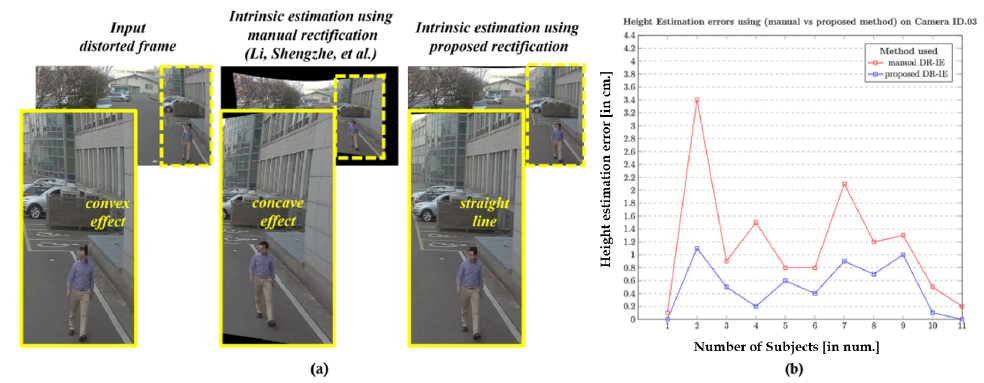
Figure 17. Height Estimation errors using (Li, Shengzhe et al. [31] vs. proposed method) on Outdoor camera ID.03: ( a ) Qualitative pixel-consistency. ( b ) Height estimation error plot corresponding to all the 11 subjects.